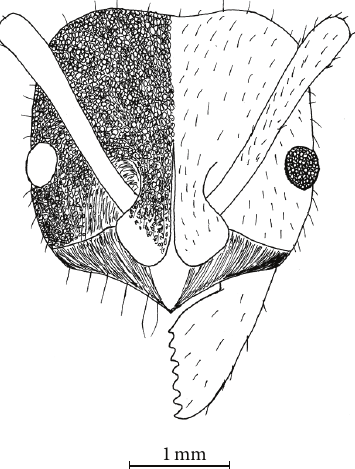
Figure 2: Full face view of the holotype worker of B. umgodikulula